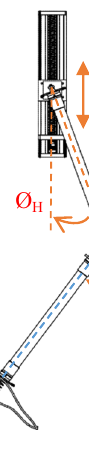
Figure 13: The inclination angle of hip and knee joint and sliding vertical motion ( up and down ) .